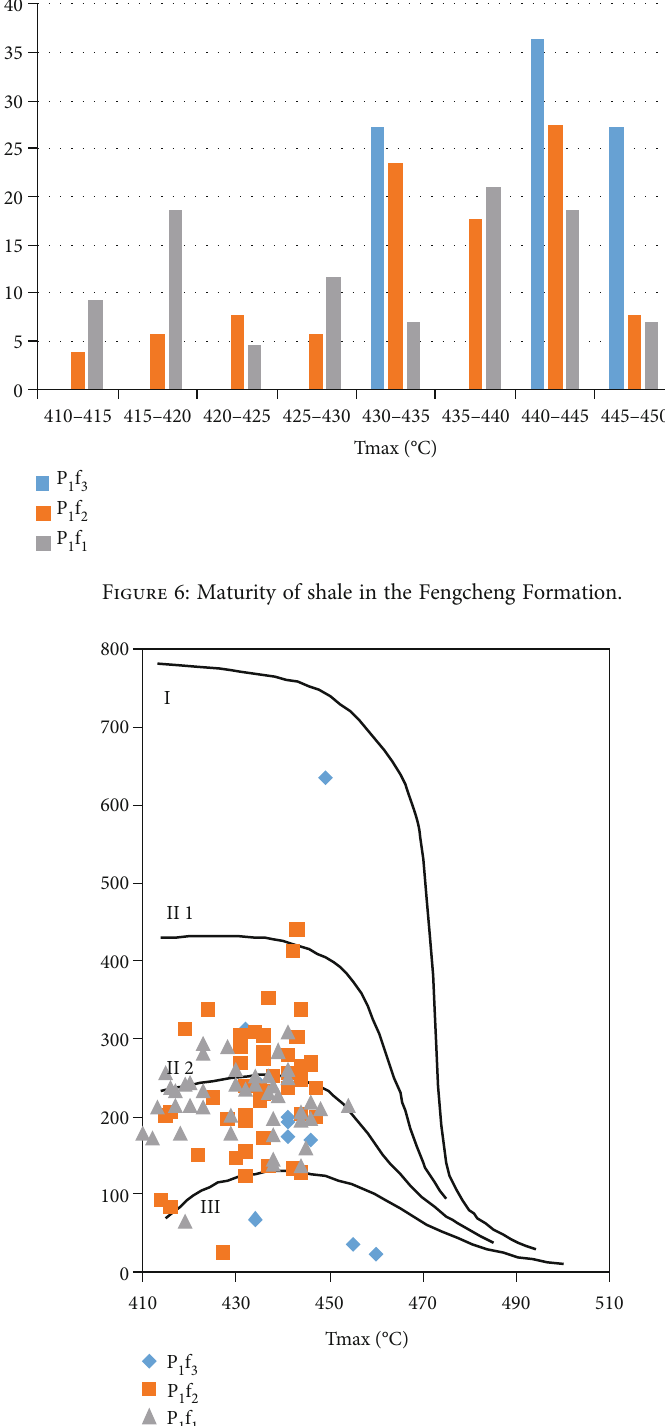
Figure 7: Classi fi cation of organic matter types in the Fengcheng